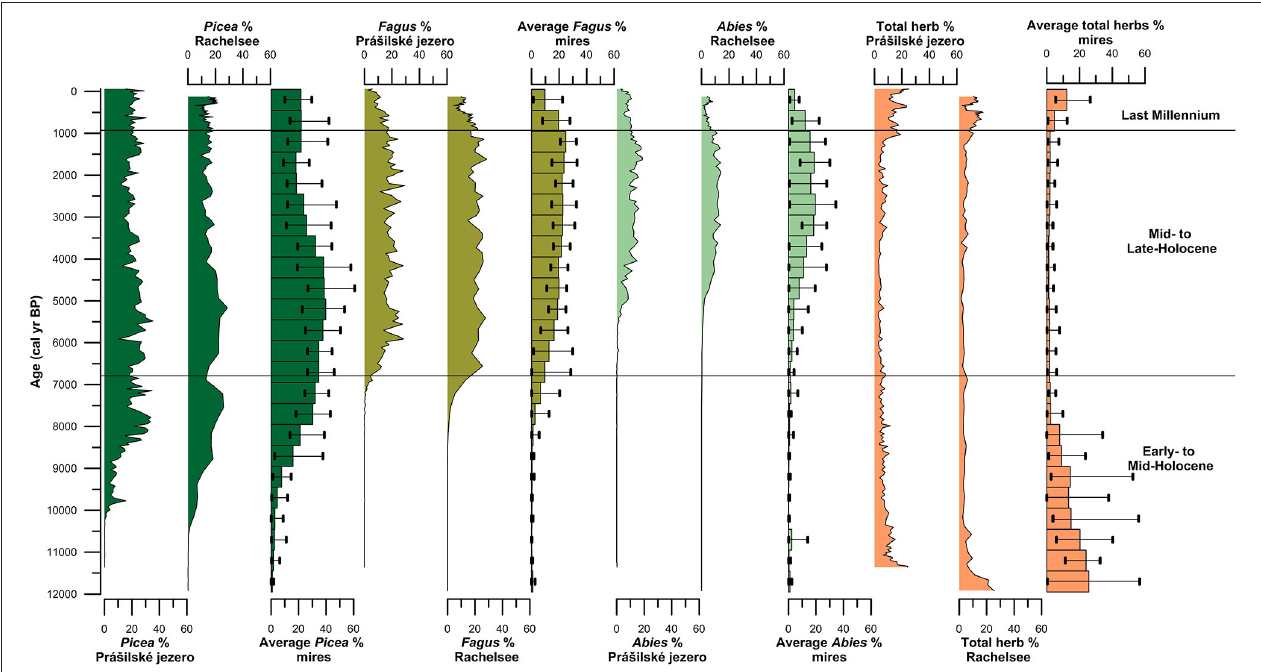
FIGURE 4 | Pollen percentages of the three dominant canopy species ( Picea , Fagus , and Abies ) and total herb percentages from Prášilské jezero and Rachelsee, as well as the average percentages and maximum/minimum percentages of all peat bog and mire sites grouped into 500 year bins.